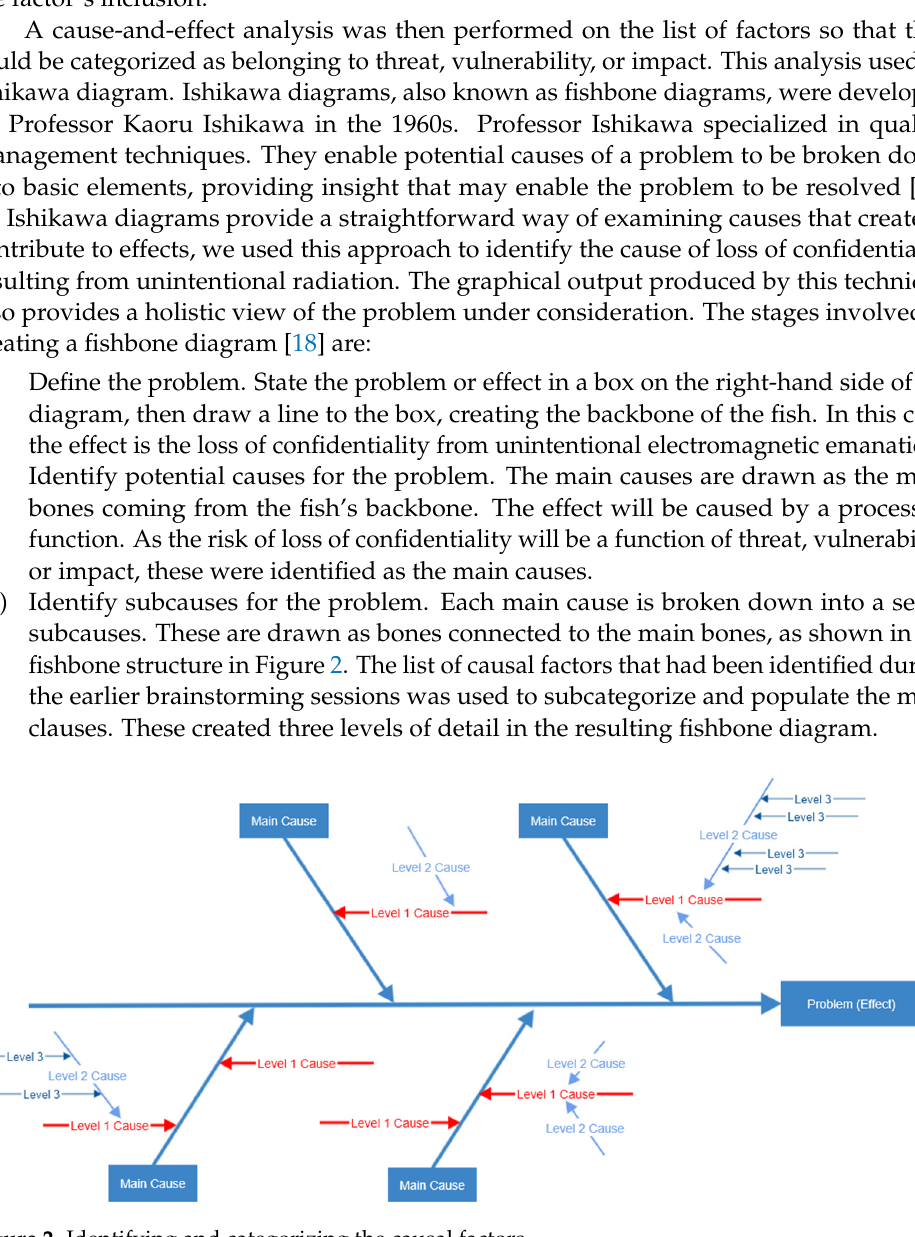
Figure 2. Identifying and categorizing the causal